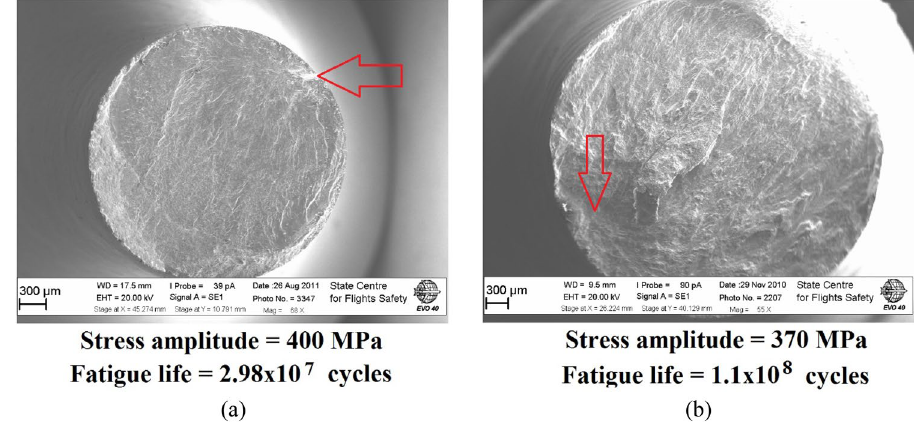
Fig. 6 Characteristic fracture surface of the specimen made of VT3-1 titanium alloy in the region of VHCF with a surface and b subsurface